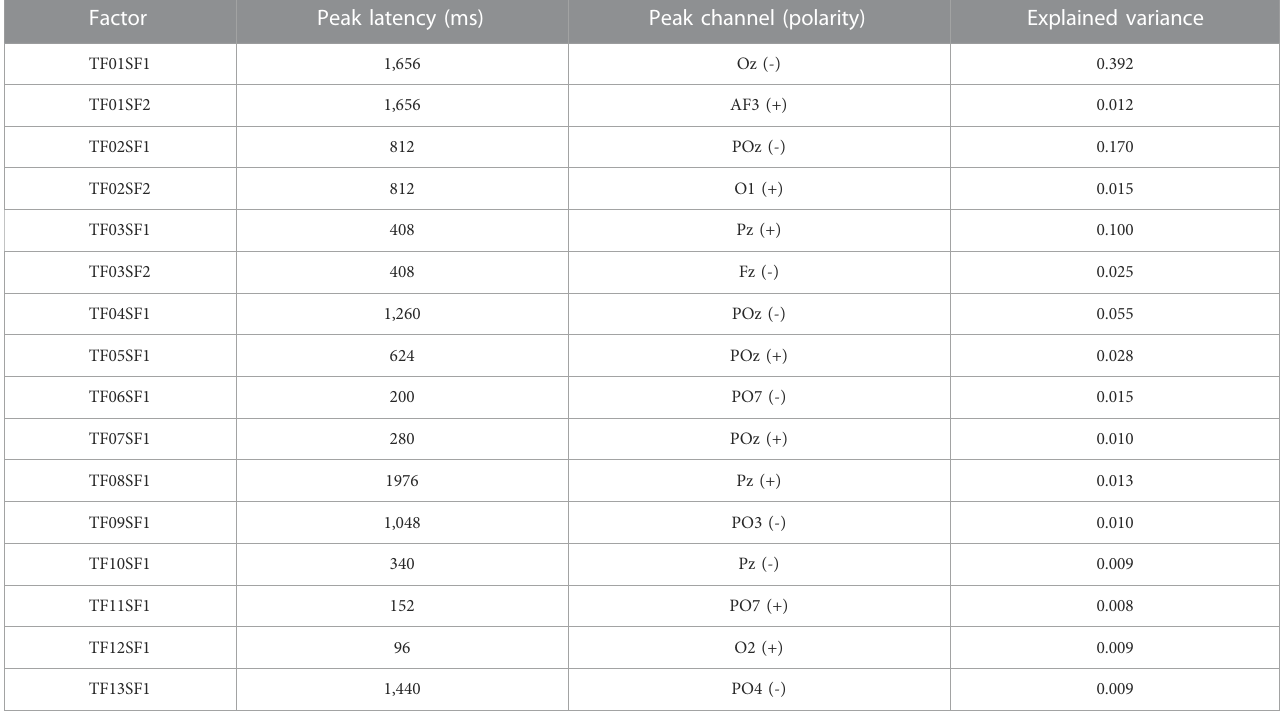
TABLE 3 Temporospatial factors (ERP components), isolated via two-steps temporospatial PCA, explaining at least 0.005 of the variance. Factor Peak latency (ms) Peak channel